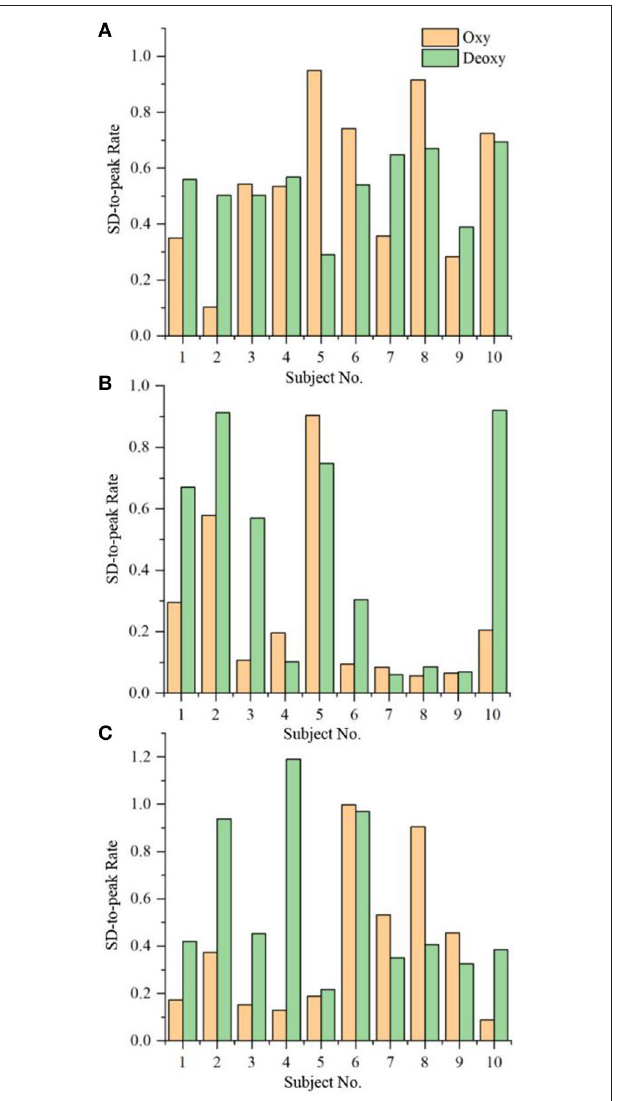
FIGURE 1 | The rate of the Oxy/Deoxy standard deviation during non-task to the maximal change (i.e., peak amplitude) during VFT task for the three groups, i.e. (A) MD, (B) , HC and (C) A&D.